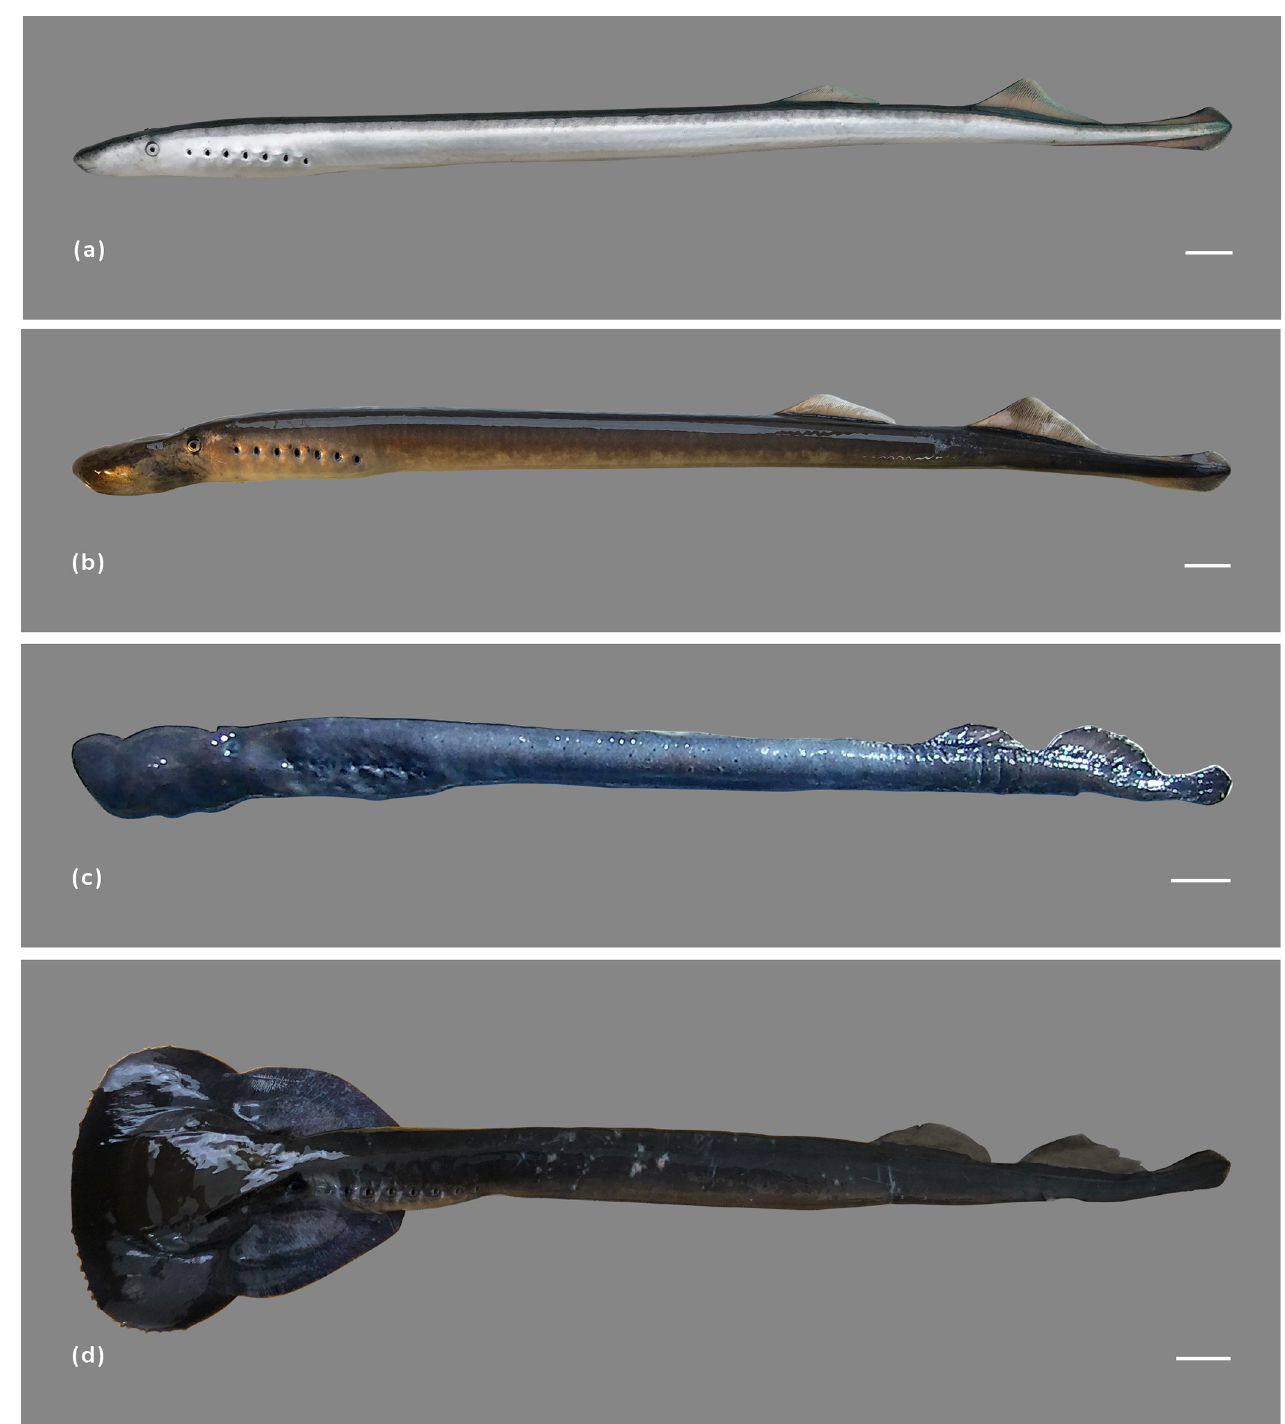
Fig 4. Immature and mature G . macrostoma . a) fresh run G . macrostoma displaying the blue-green coloration to the dorsal region, the silver/white ventral surface and the iridescent blue markings along the trailing edges of the dorsal fins and along the entire edge of the caudal fin as well as the fleshy tip of the tail, b) G . macrostoma after six weeks in fresh water lacking the blue-green coloration to their dorsal region and the loss of iridescent markings to the fin tip, c) sexually mature female G . macrostoma (assumed post-spawning), d) sexually mature male G . macrostoma (assumed post-spawning). Scale bars = 2 cm.